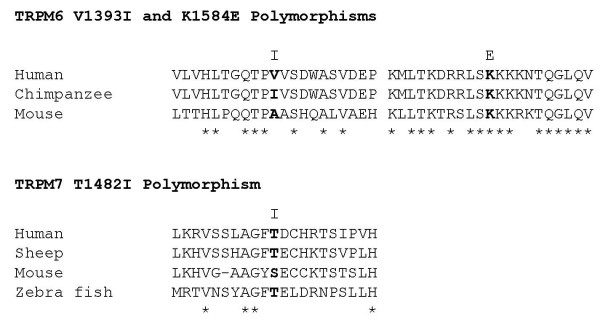
Cross-species comparison of the protein sequences of (A) two TRPM6 segments encompassing the two non-synonymous SNPs, V1393I and K1584E (21 amino acids each, centered at the non-synonymous SNP) in human (GenBank accession number Q9BX84), chimpanzee (GenBank accession number XP_528327), and mouse (GenBank accession number Q8CIR4); and (B) a TRPM7 segment encompassing the non-synonymous SNP, T1482I (21 amino acids, centered at the non-synonymous SNP) in human (GenBank accession number Q96QT4), Sheep (GenBank accession number ABP35923), mouse (GenBank accession number Q923J1), and zebra fish (GenBank accession number NP_001025232). The asterisks denote amino acid residues conserved across all the species that were compared.